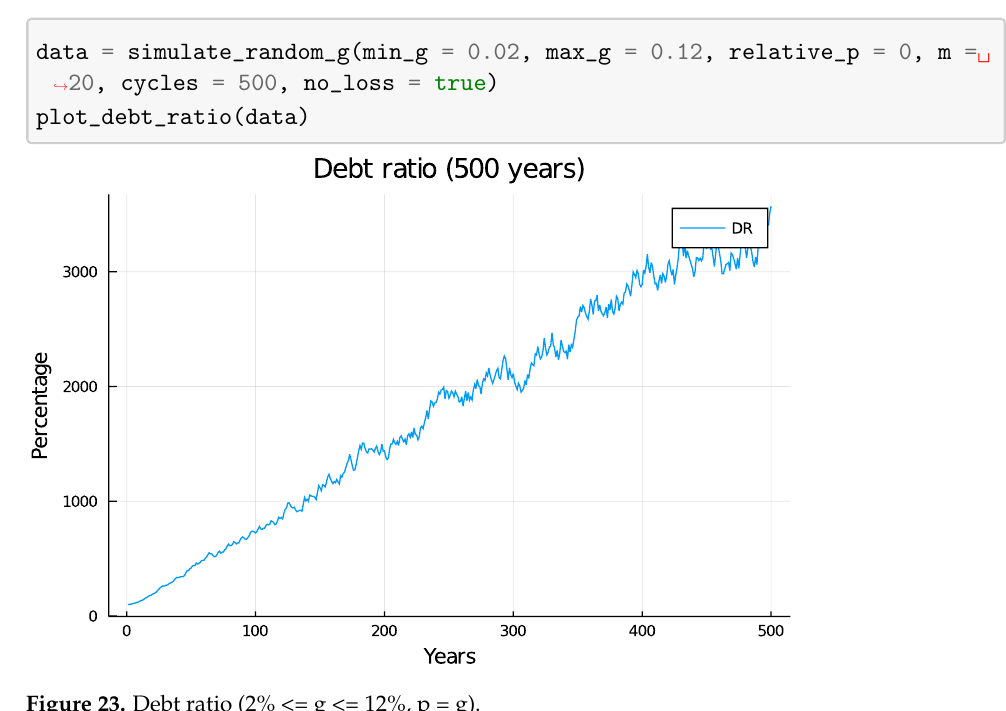
Figure 23. Debt ratio (2% <= g <= 12%, p = g).